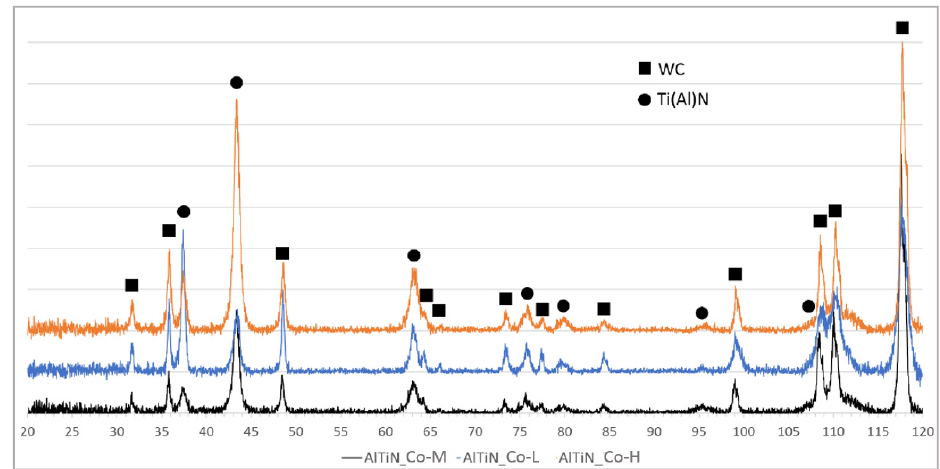
Figure 2. XRD analysis graph of 5 µm thick TiN/AlTiN coating deposited on three different cemented carbide substrates: Co-L, Co-M and Co-H.